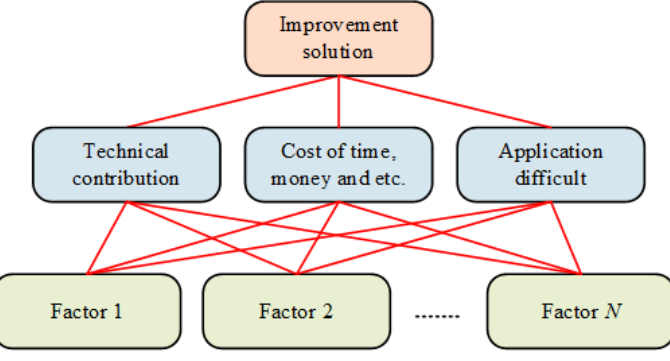
Figure 4. Hierarchical evaluation of improvement solution.